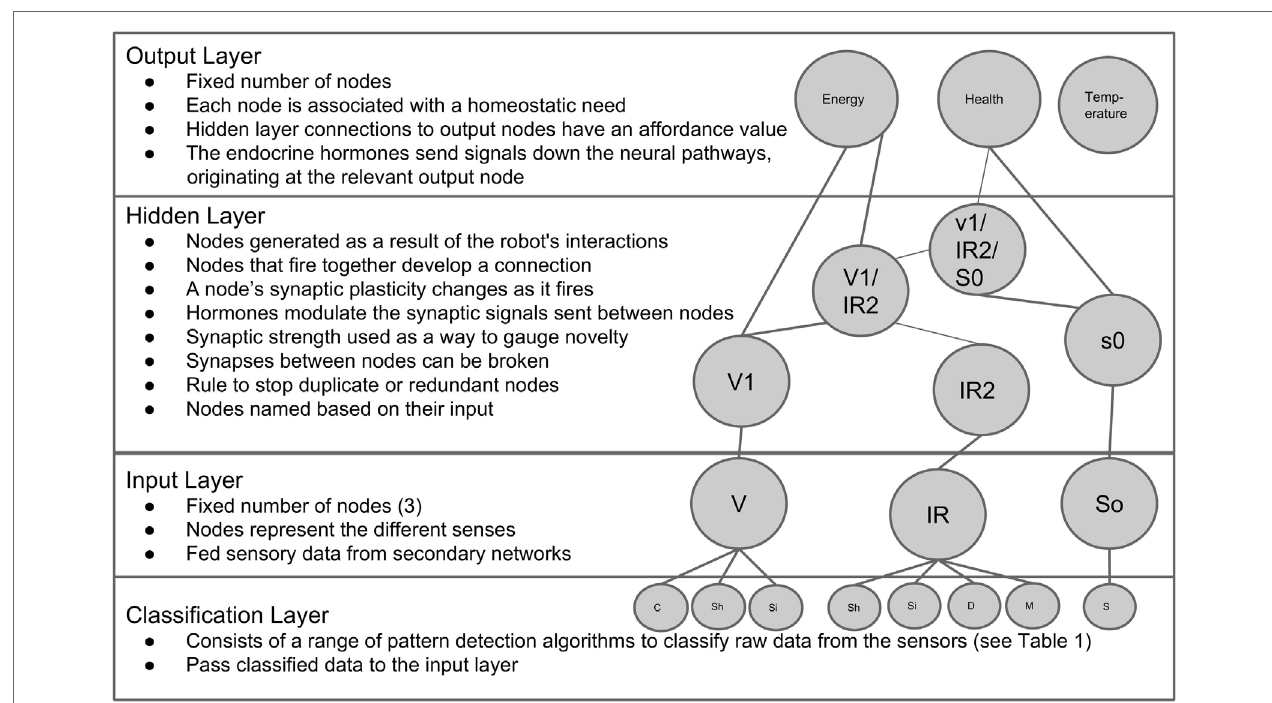
FigUre 2 | an example of the basic structure of the neural network